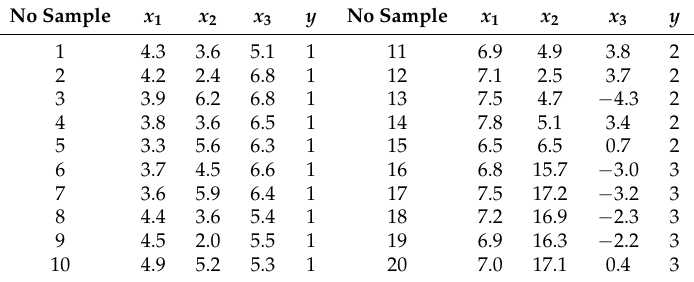
Table A1. Data set used in the numerical example.